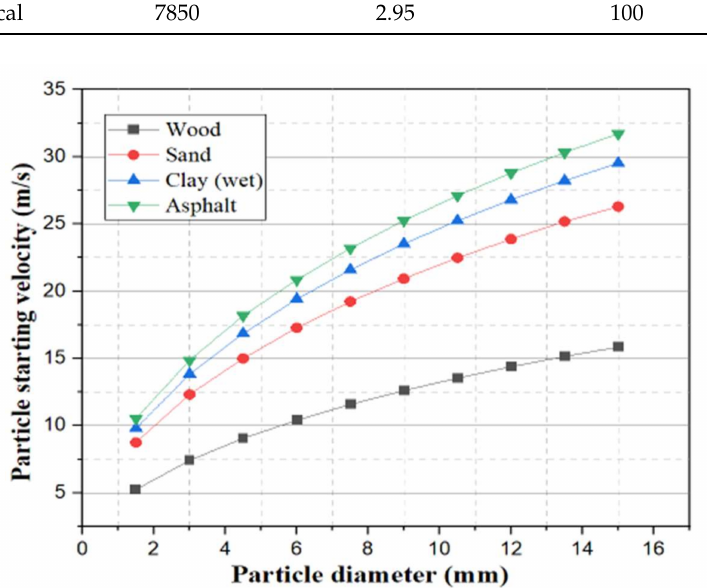
Figure 4. The particle pick-up velocity of the air when it begins to pull from the particle layer. The difference in particle uptake rate can be seen with increasing particle